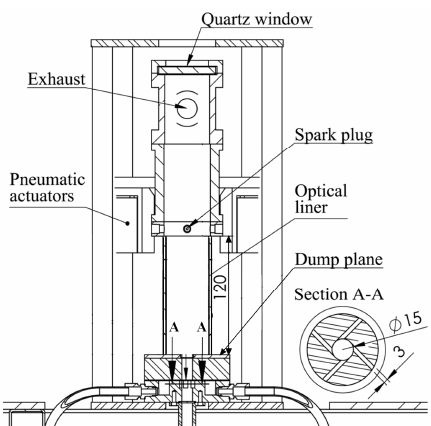
Figure 3. Cross section of the plane of symmetry of the combustor (unit: mm).